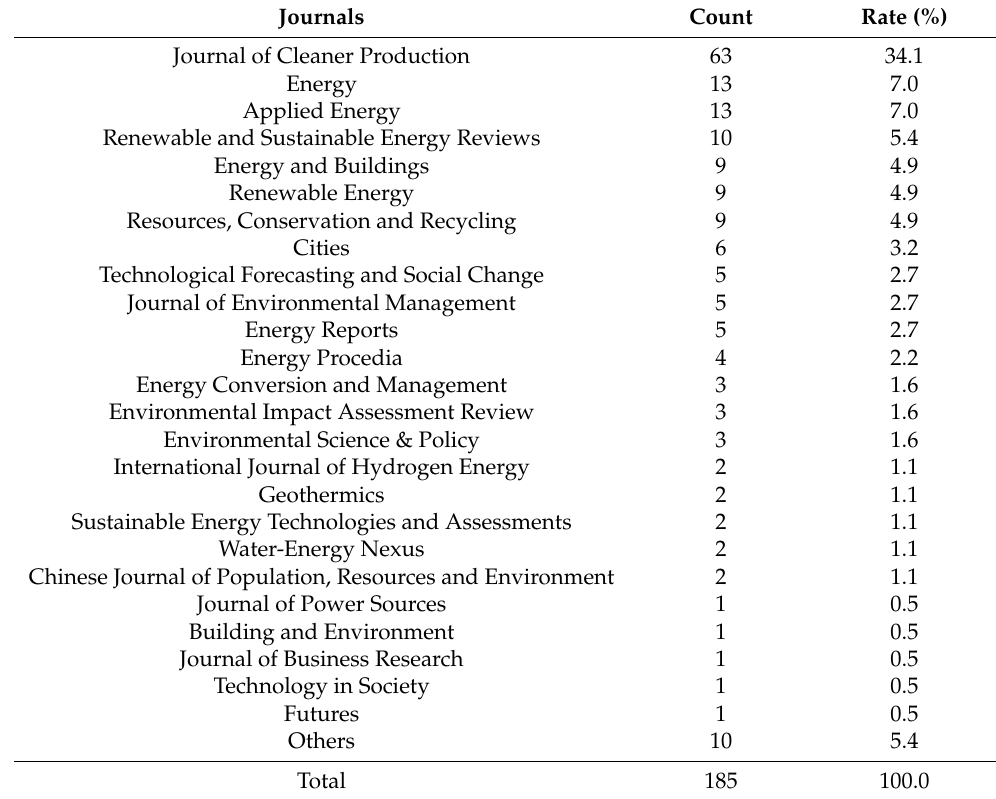
Table 2. Journals of ‘urban energy management’ or ‘city energy management’ research.